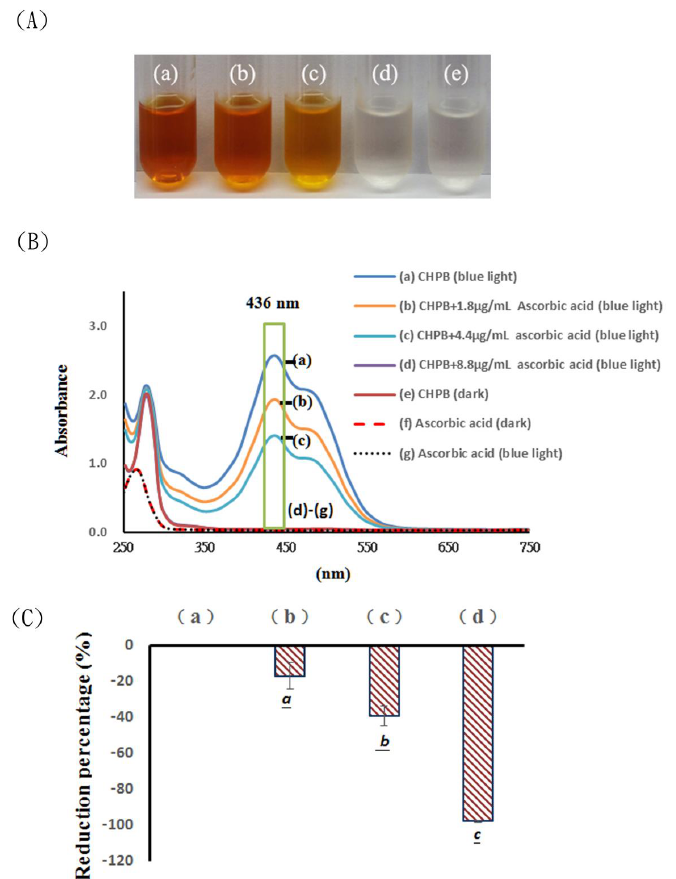
Figure 2. ( A ) Color changes of 290 µ g/mL (catechin hydrate in 0.1 M phosphate buffer solution) CHPB treated ( a ) without and with ( b ) 1.8, ( c ) 4.4, and ( d ) 8.8 µ g/mL of ascorbic acid, respectively, under blue light irradiation at 2.0 mW/cm 2 for 120 min, and ( e ) in the dark. ( B ) The absorption spectra of 290 µ g/mL CHPB treated ( a ) without and with ( b ) 1.8, ( c ) 4.4, and ( d ) 8.8 µ g/mL of ascorbic acid, respectively, under blue light irradiation at 2.0 mW/cm 2 for 120 min, and ( e ) in the dark. The absorption spectra of 17.6 µ g/mL ascorbic acid solutions treated ( f ) without and ( g ) with blue light irradiation at 2.0 mW/cm 2 for 120 min. The reaction solutions were measured in the spectral range of 250–750 nm. ( C ) The effects of ascorbic acid on absorbance at 436 nm. The reduction percentage at 436 nm of 290 µ g/mL CHPB treated ( a ) without and with ( b ) 1.8, ( c ) 4.4, and ( d ) 8.8 µ g/mL of ascorbic acid, respectively, under blue light irradiation at 2.0 mW/cm 2 for 120 min. Data are represented by mean ± standard deviation (SD), where n = 3. Statistical differences ( p < 0.05) between groups are indicated by different letters below each